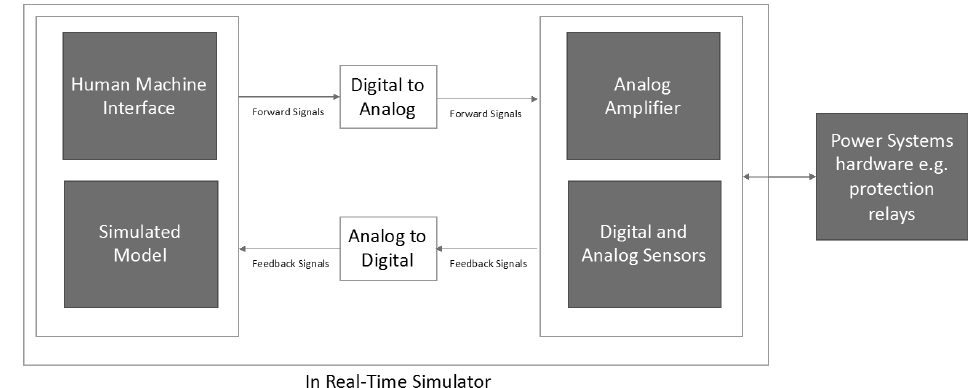
Figure 5. Basic Hardware in the loop simulation concept [83].